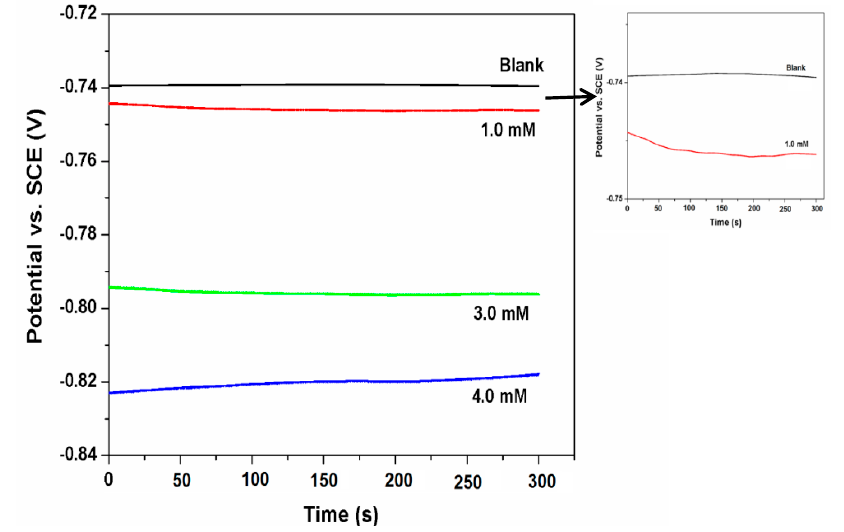
Figure 3. Open circuit potential versus time curves for AA 6061 in 1 M HCl without and with inhibitor at 303 K.